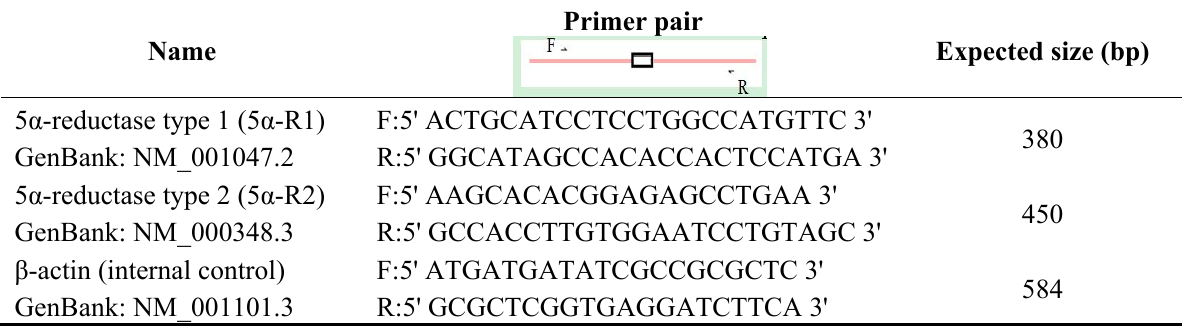
Table 2. Forward and reverse primers and expected sizes of 5 α -Rs and β